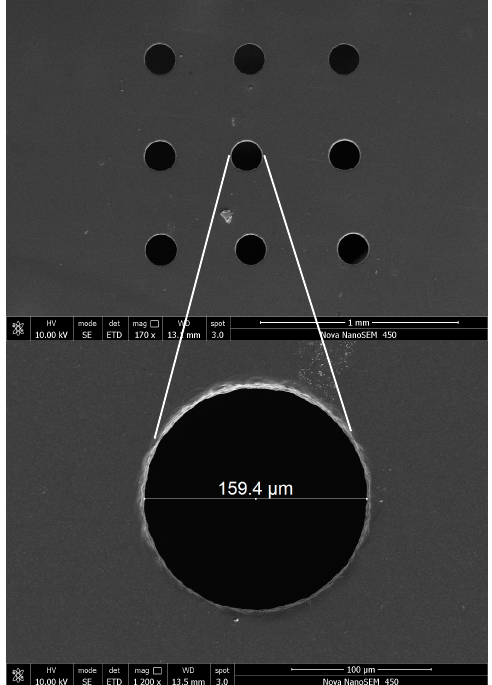
Figure 9. Array micro holes and partial magnification